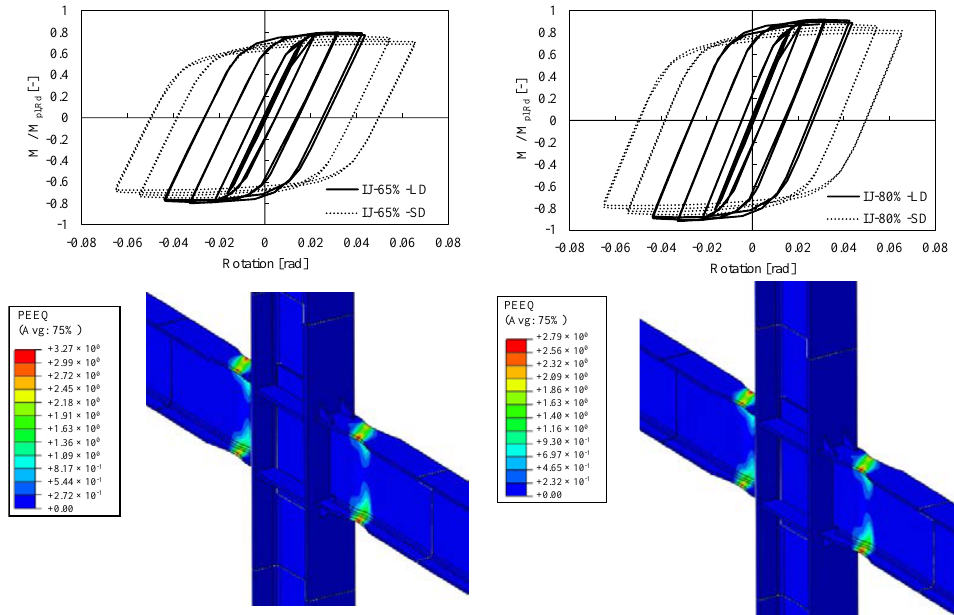
Figure 7. Cyclic behaviour of the investigated joints in terms of moment–rotation curves and equivalent plastic deformation (PEEQ).